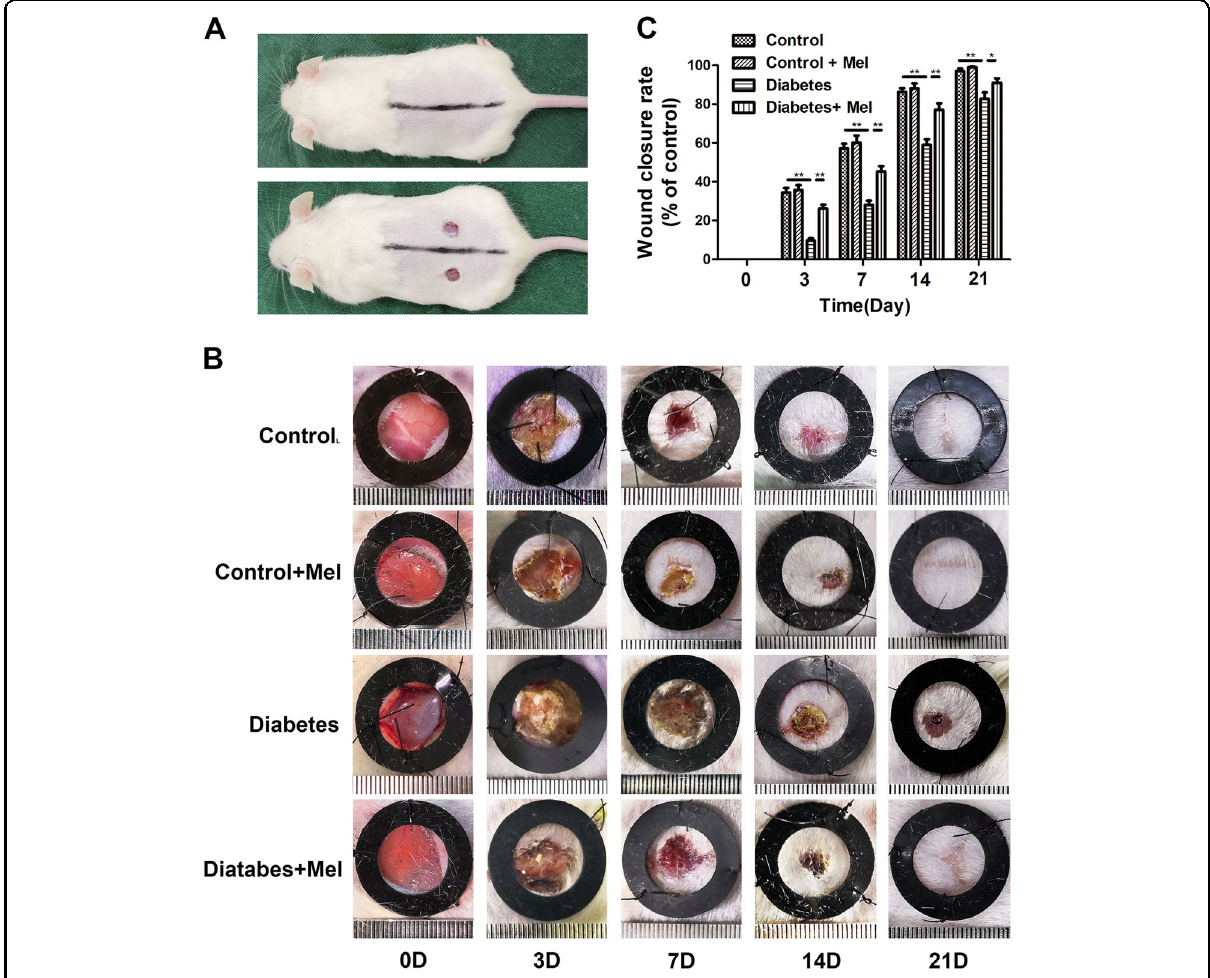
Fig. 6 Melatonin accelerates wound closure. a Two rounds of full-thickness dermal wounds were made on both sides of the dorsal trunk. b Representative images of wound closure are shown in the control, control + melatonin, diabetes, and diabetes + melatonin groups on days 0, 3, 7, 14, and 21. c Wound closure rates of the four groups at the indicated times. Data are presented as the mean ± SEM. Signi fi cant differences between the treatment and control groups are indicated as ** P < 0.01 or * P < 0.05. n =